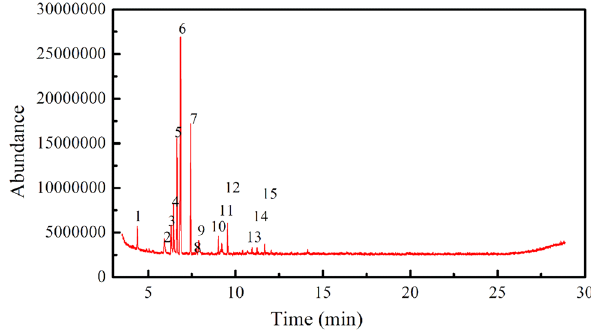
Figure 4: GC - MS spectrum of the bio - oil from dry navel peel and CaO pyrolysis bio -